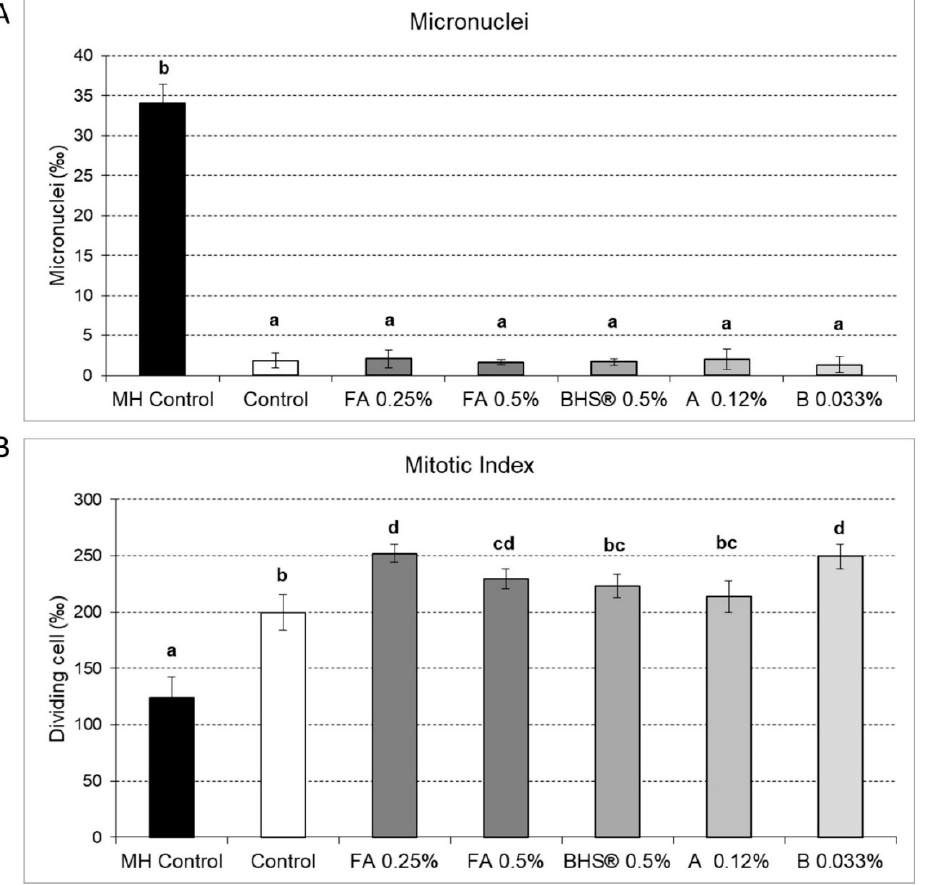
Figure 2. ( A , B ) Scoring of Micronuclei ( A ) expressed as the number of micronuclei per 1000 cells observed and of mitotic indices ( B ), expressed as the number of dividing cells per 1000 cells observed in the root apices of Vicia faba after 56 h of treatment: non-exposed (Control) or exposed to Maleic hydrazide at 1.12 mg.L − 1 (MH Control), or to different commercial products: fulvic acids at 0.25% (FA 0.25%), 0.5% (FA 0.5%), biomimetic humic substances (BHS ® 0.5%), and products A or B (Histograms marked with the same letter are not statistically different at p < 0.05).